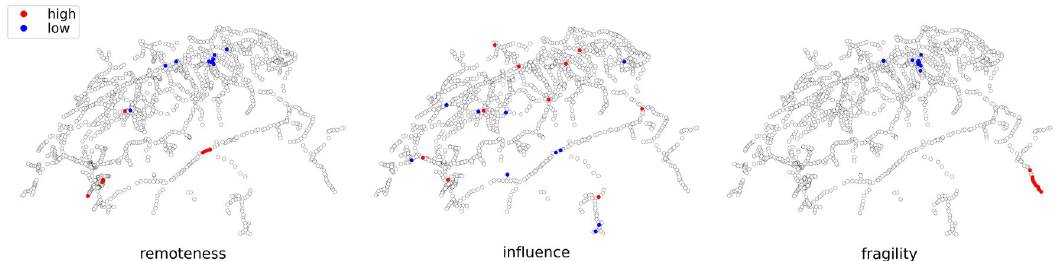
Fig 8. Ten highest and lowest values of selected measures, 1 month